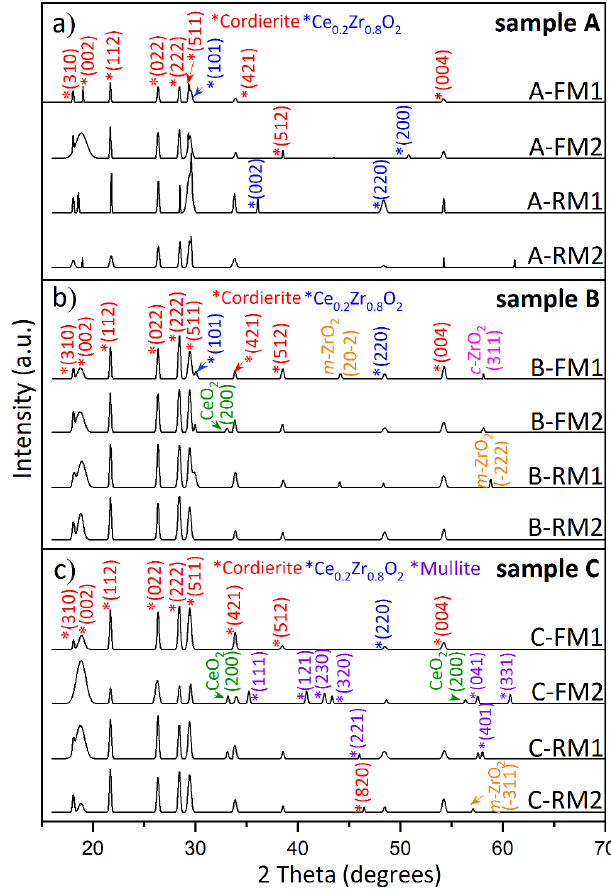
Figure 5. XRD diffractogram for ( a ) new; used ( b ) B-TWC and ( c ) C-TWC. Cordierite (red labels) is present in all ceramic monoliths, and phase change to mullite (purple labels) is only observed in the highly used catalyst.